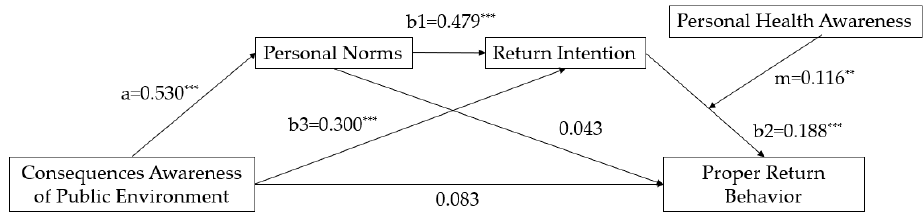
Figure 3. Estimation of moderated mediation model. Note: *** p < 0.01, ** p < 0.05. Table 3. Mediating effect and 95% confidence interval estimated by Bootstrap